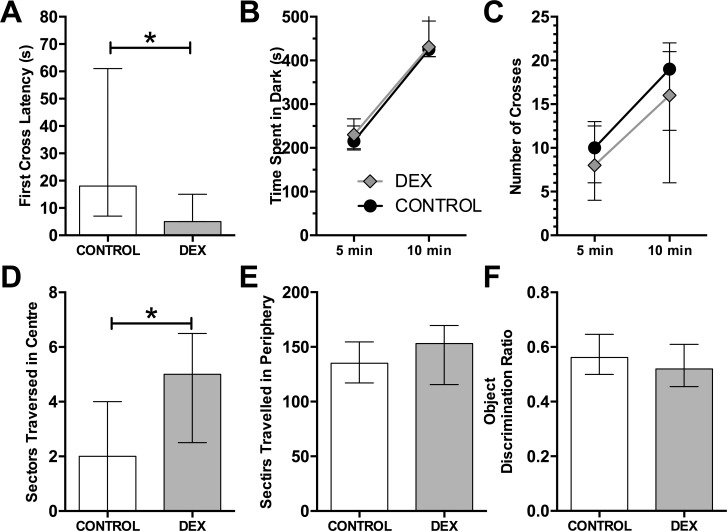
Behavioural testing outcomes with dexamethasone treatment.The light-dark tunnel (A to C), open field (D & E) and novel object recognition (F). Light-dark tunnel: A) Latency to first cross from dark to light side, B) total time spent in dark in 5 and 10 min, C) total number of crosses between light and dark. Selected open field exploration data: D) & E) show the Median number of centre and peripheral sectors travelled respectively. F) Discrimination ratio from novel object recognition. Statistics were Wilcoxon ranked sum. There were no significant differences. Data represent median ± inter-quartile range. Significant differences: * p < 0.05.